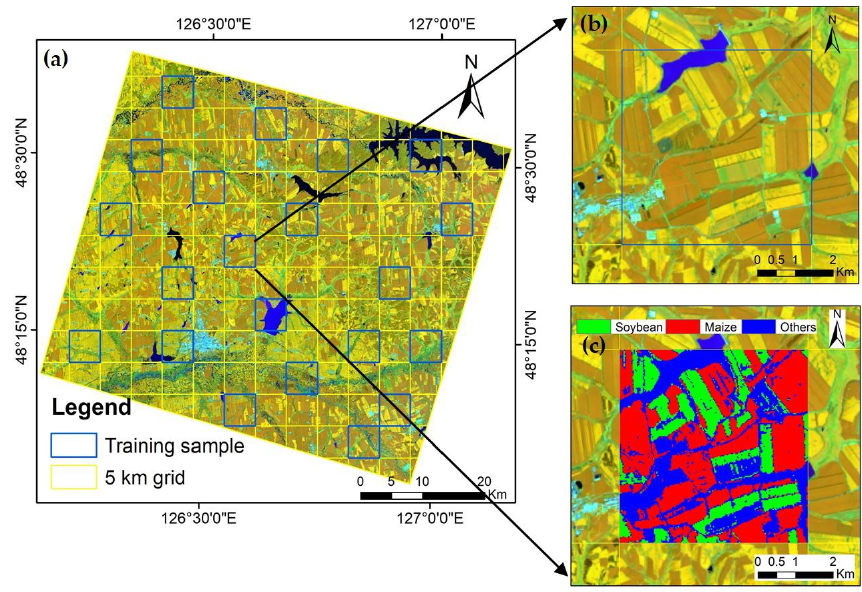
Figure 3. Landsat image (SWIR1/NIR/Red as R/G/B) and the distribution of sample blocks ( a ), the enlargement of one sample block ( b ), and its classification ( c ).